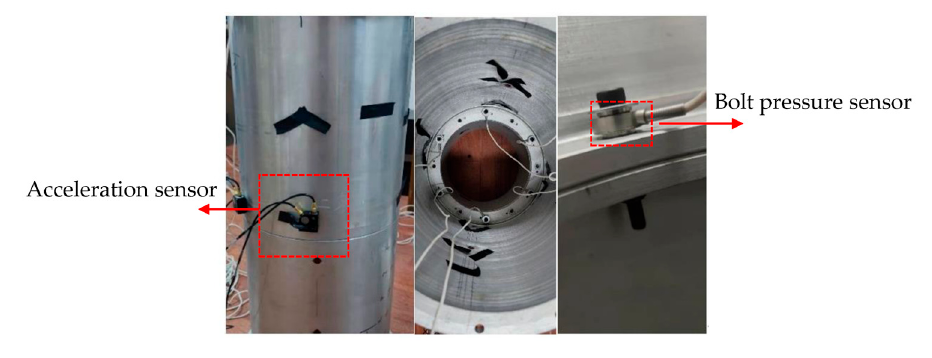
Figure 21. Experimental equipment.